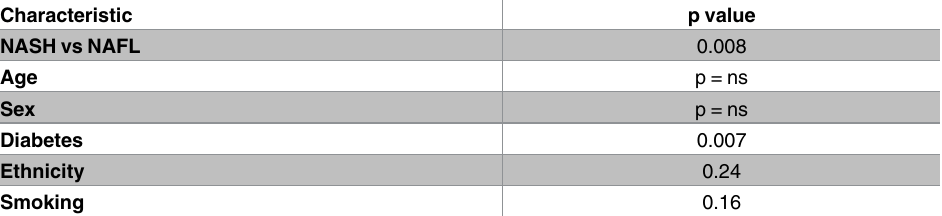
Table 5. Spearman correlation of periodontitis with patient